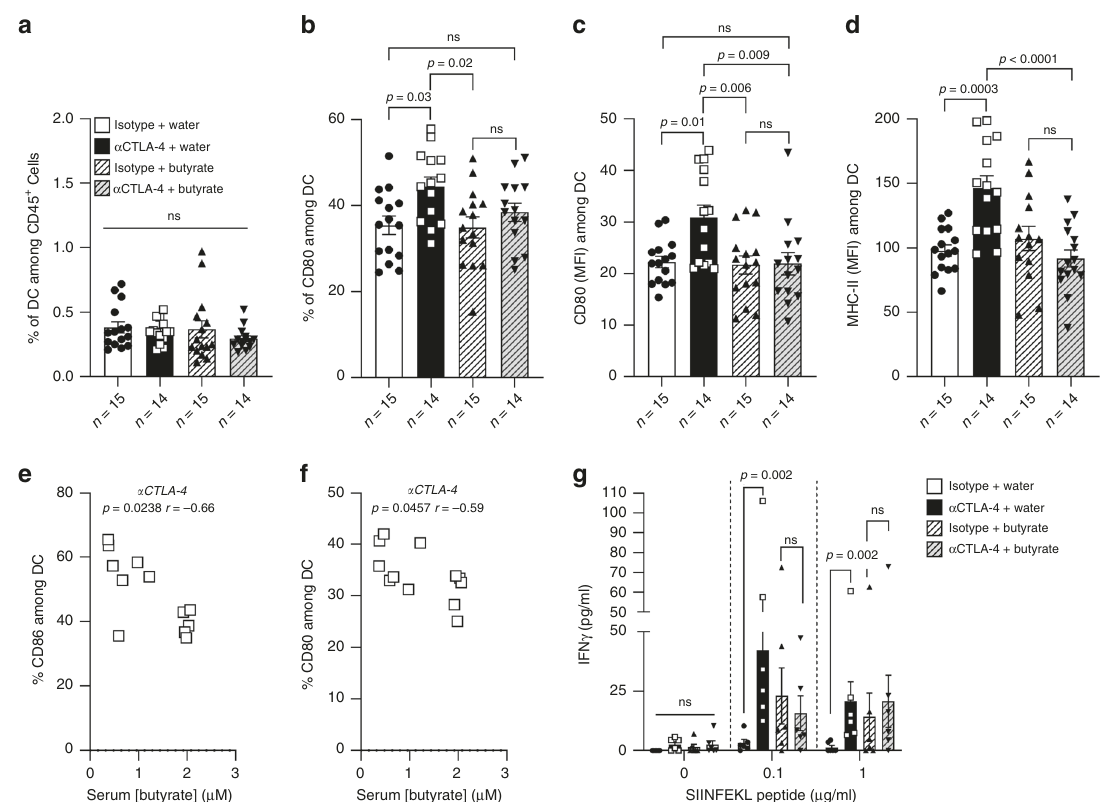
Fig. 4 Sodium butyrate inhibited anti-CTLA-4-induced DC maturation and T cell priming. a Percentages of dendritic cells (DC de fi ned as CD3 - CD19 − NKp46 − CD11c + MHC-II + among CD45 + cells) in tDLN from three pooled independent experiments. b Percentages (%) of CD80 among DC in the tDLN from pooled independent experiments. c Mean fl uorescence intensity of CD86 among DC in the tDLN. d Mean fl uorescence intensity (MFI) of MHC class- II among DC in the tDLN. e , f Correlation between the percentage of CD86 ( e ) and CD80 ( f ) and serum butyrate concentration in mice treated with anti- CTLA-4 ( n = 12 mice) g IFN γ concentration after ex vivo restimulation of tDLN with MHC-I OVA (SIINFEKL) peptides from one representative experiment out of two independent experiments ( n = 6 mice per group). p -values are indicated on each graph; Each dot represent one mouse ( a , b , c , d , e , f and g ). n (number of mice per group) is indicated on the graph ( a , b , c and d ). Bars represent mean + / − sem ( a , b , c , d and g ). One-way ANOVA followed by Tukey ’ s tests for multiple comparisons was used ( a , b , c and d ). Spearman test were used ( e and f ). Two-tailed Mann – Whitney tests were used ( g ). p- values are indicated on each graph; ns, not-signi fi